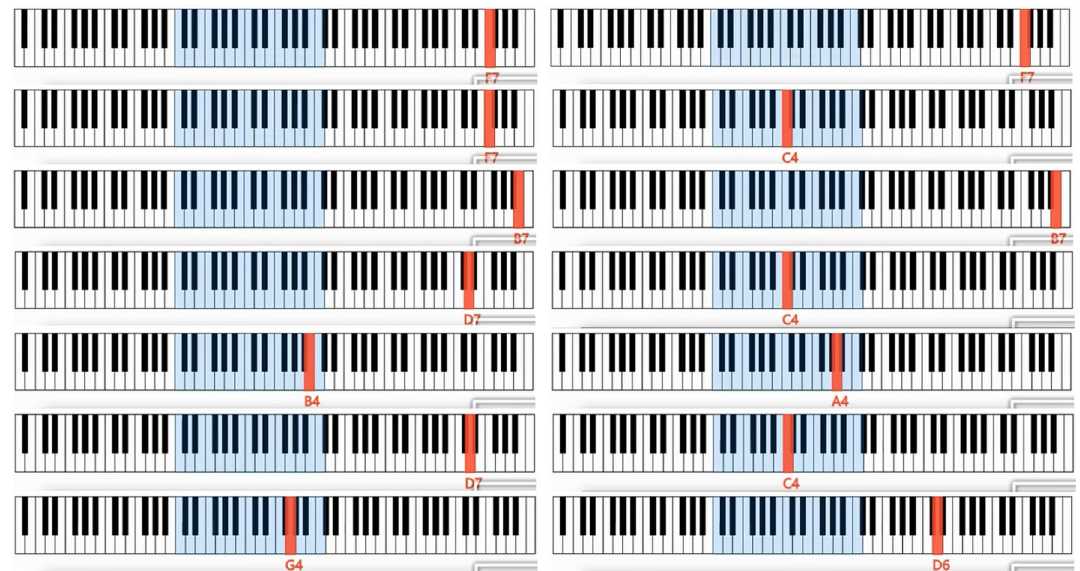
Figure 6. An example on AAQRC recognition: step 3: music score of f3’.